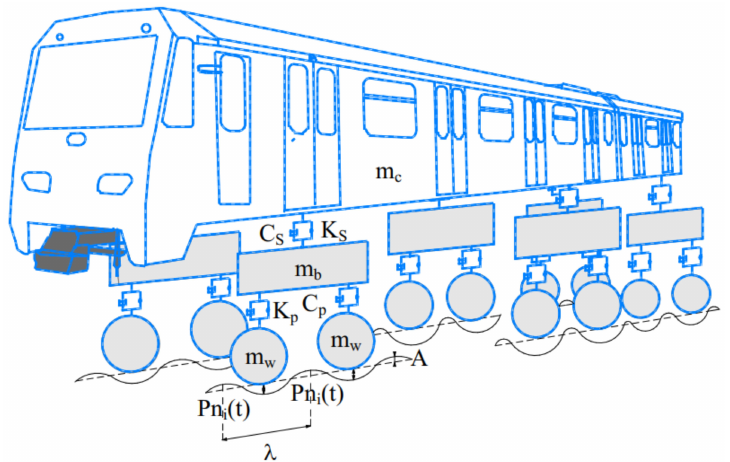
Figure 5. Metro-train